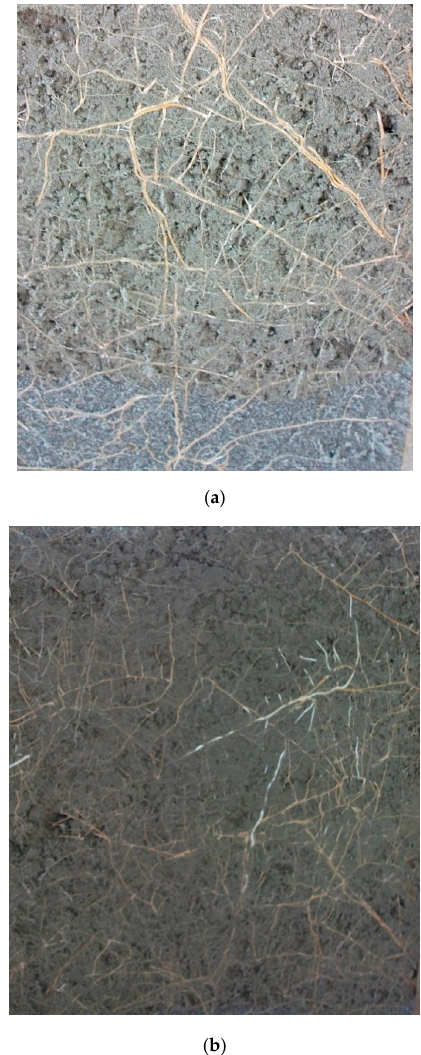
Figure 1. ( a ) Contrasting root growth in silt and sand layers. Note the greater number of very fine roots in the silt. ( b ) Characteristic root development in silt dominated by very fine roots and high production of new roots visible as white